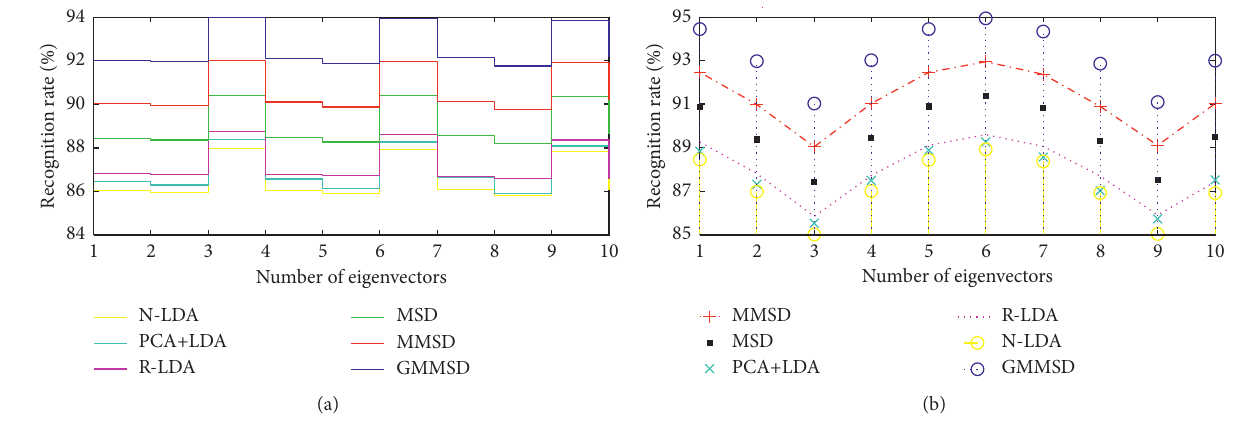
Figure 6: Average recognition rate of faces. (a) Jaffe face library. (b) RML face library.